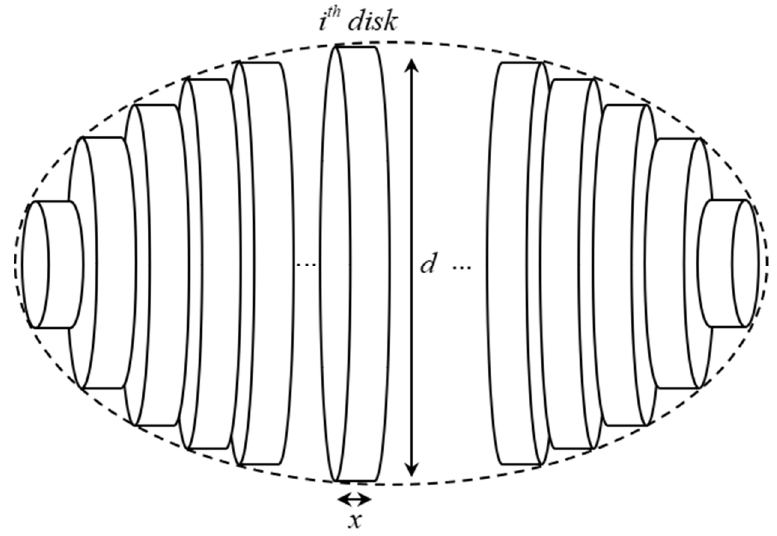
Figure 1. An example object is sliced into many disks.